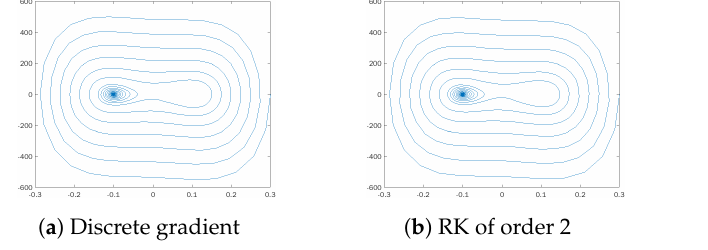
Figure 2. Phase portrait for h = 10 − 5 .